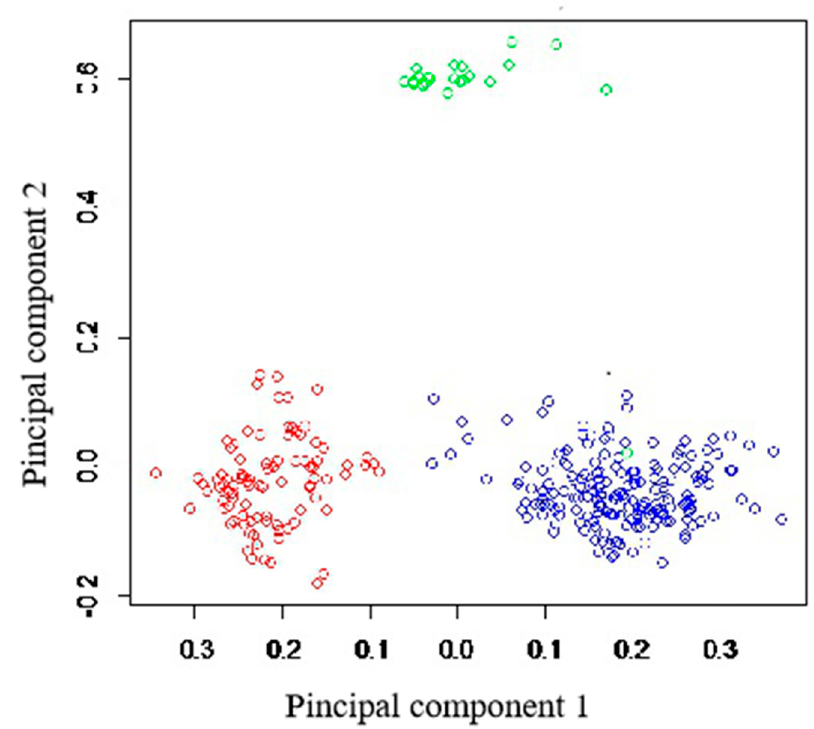
Figure 4. Principal coordinate analysis with Bruvo distances, based on molecular data displaying population structure of Kashmir and Quebec invasives and Quebec native Phragmites between principal component analysis (PCA) 1 and PCA 2 (Blue—Quebec invasive populations; Green—Quebec native population; Red—Kashmir invasive populations).